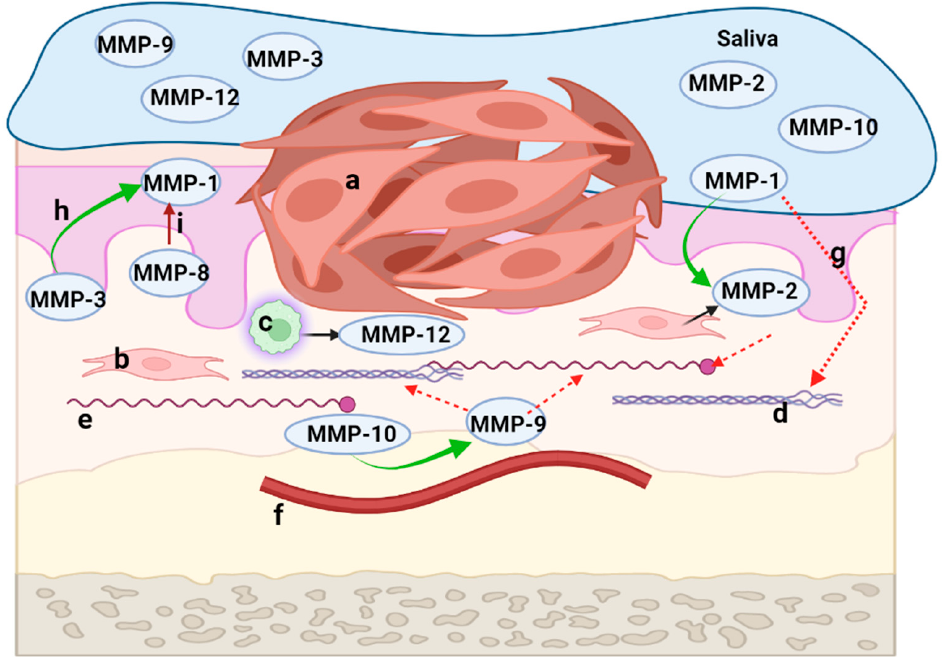
Figure 1. MMPs activity in the tumor microenvironment of OSCC facilitates invasion through the digestion of ECM components. MMP ‐ 1 degrades collagen type I and activates MMP ‐ 2; MMP ‐ 2 is released from fibroblasts at the invasive front and degrades collagen type IV. MMP ‐ 3 contributes to tumor invasion by activating MMP ‐ 1. MMP ‐ 8 (by inactivating MMP ‐ 1) and MMP ‐ 12 (when released from macrophages) may have protective effects. MMP ‐ 9, which is activated by MMP ‐ 10, degrades both type I and type IV collagen. All these MMPs can also be found in the saliva of patients with OSCC. (Figure legend: a = primary tumor, b = fibroblast, c = macrophage, d = collagen type I, e = collagen type IV, f = blood vessel, g = interrupted red arrow, suggesting degradation effect, h = green arrow, suggesting activation, i = continuous red arrow, suggesting inhibition).